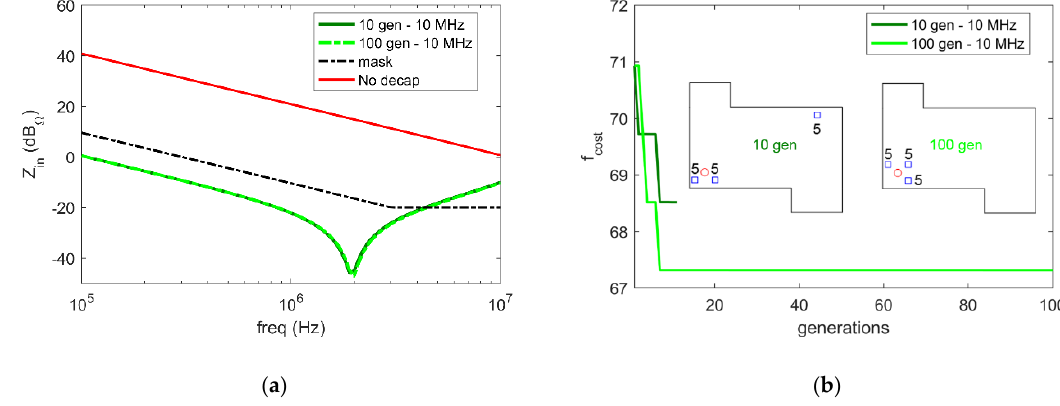
Figure 12. ( a ) Result of the optimization in DF PI up to 10 MHz after 10 generations (solid green line) and 100 generations (dotted – dashed light green line) compared with the mask and the case without decaps. ( b ) Cost function f cost as function of the number of generations when max gen = 10 and max gen = 100. The insets show the decaps placement after as max gen changes its value and the number of elementary decaps in each position. The red circle represents the input port and the blue squares the position for the decaps.